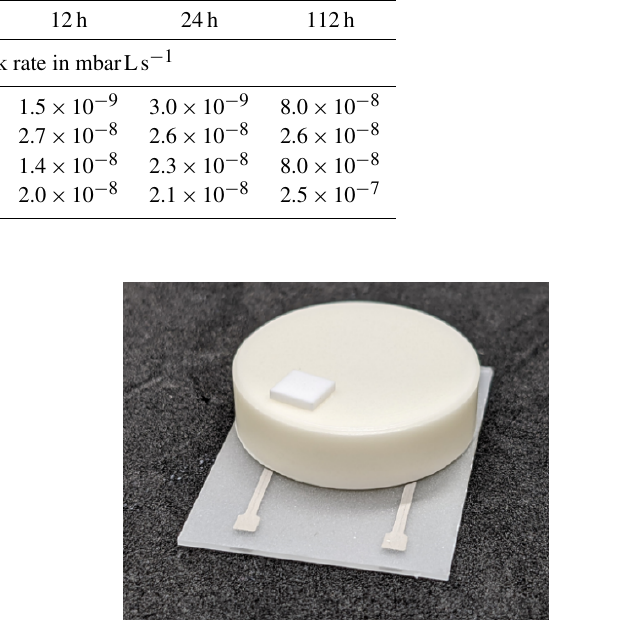
Figure 23. Realised sensor housing for the piezoelectric CTGS res- onator as a temperature